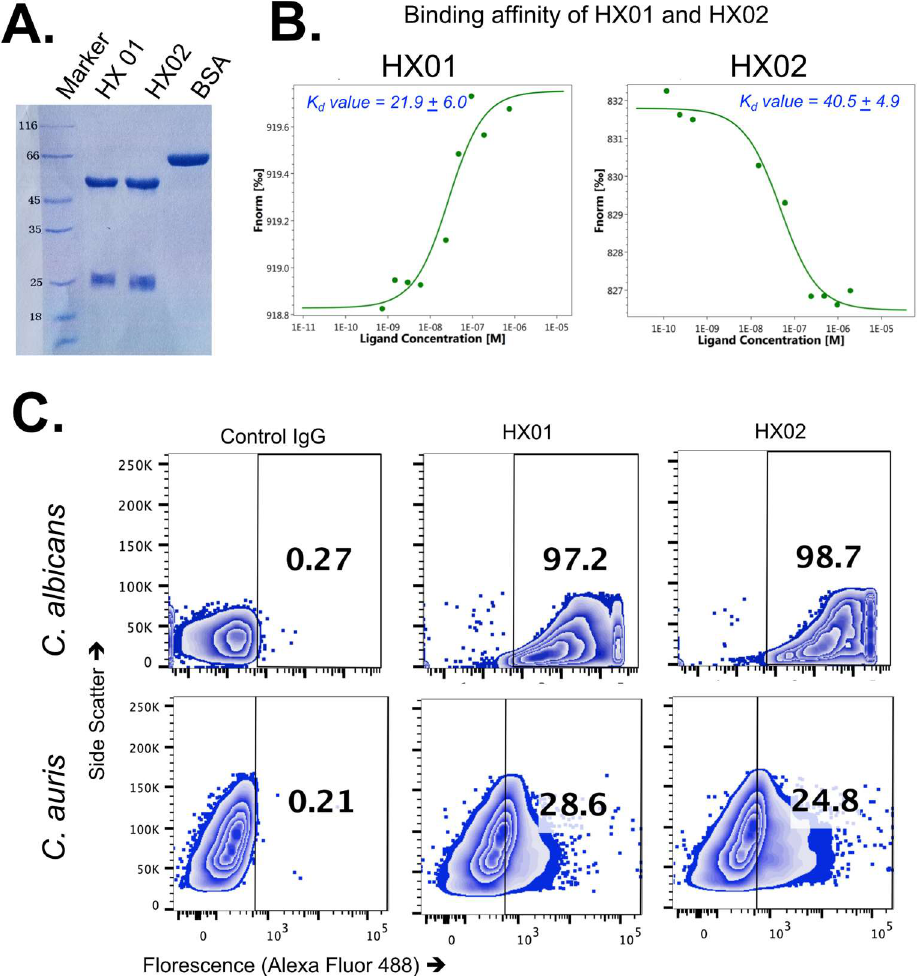
Figure 3. Binding activity of purified anti-Cal-Hyr1 MAbs. ( A ) An amount of 3 µg of purified HX01, HX02, or BSA was loaded on the SDS page to determine its purity. ( B ) HX01 and HX02 binding affinities were determined against Hyr1 peptide#5 conjugated with BSA. Antibody concentrations are plotted against fluorescent signal captured. Data are the average of three independent experi- ments. ( C ) Each organism (pre-germinated C. albicans SC5314, C. auris (CAU-09)) had 2 × 10 6 cells incubated with 10 µg/mL of HX01 and HX02 MAb or an isotype-matched control IgG1. Bound an- tibodies were detected by anti-mouse IgG1 labeled with Alexa Fluor 488. The extent of binding was quantified by flow cytometry. Data are presented in a zebra plot highlighting the percentage of each organism that was bound by each Ab.